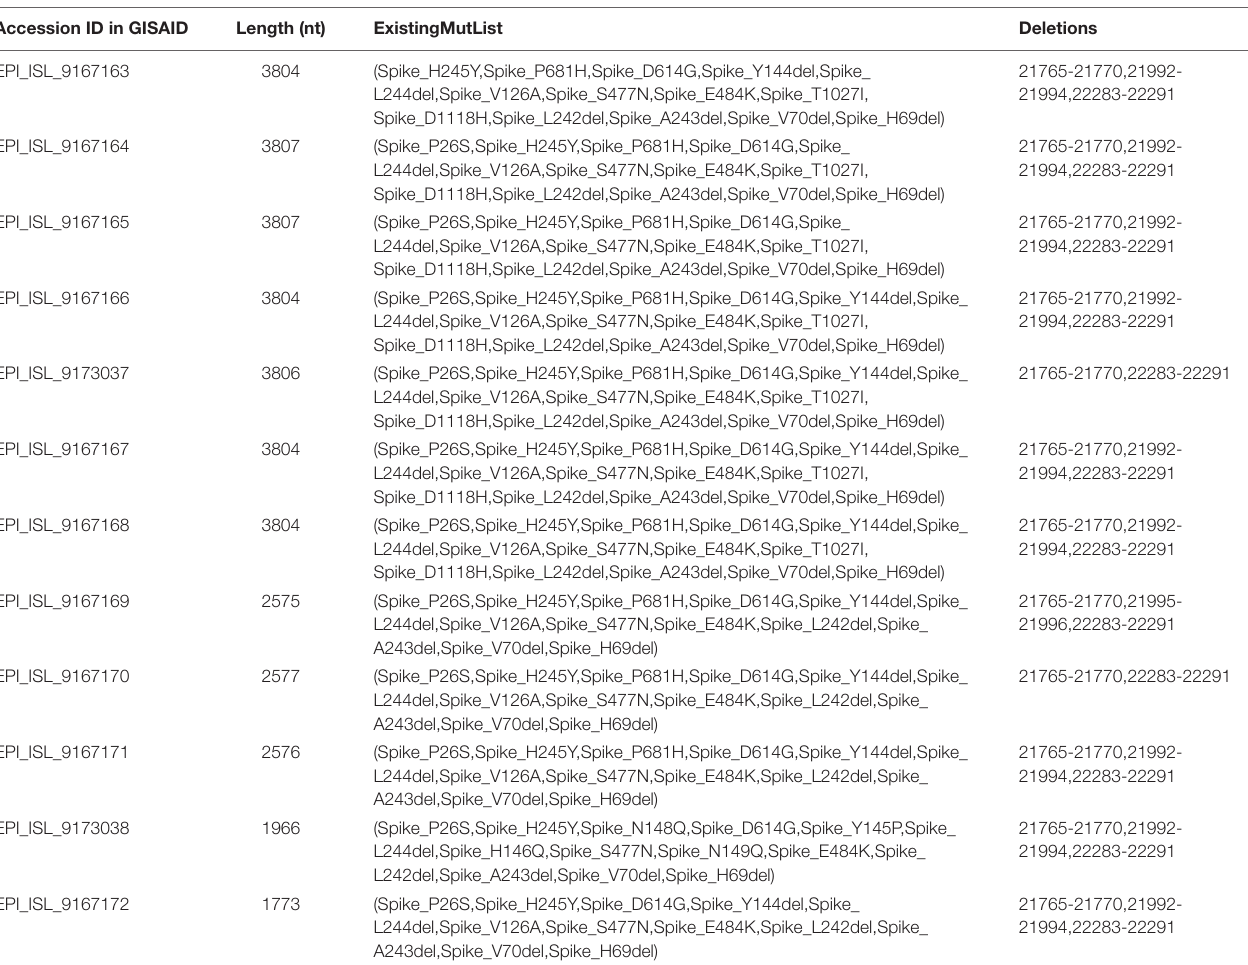
TABLE 2 | Spike protein mutations with their locations identified using 12 sequences of general hospital